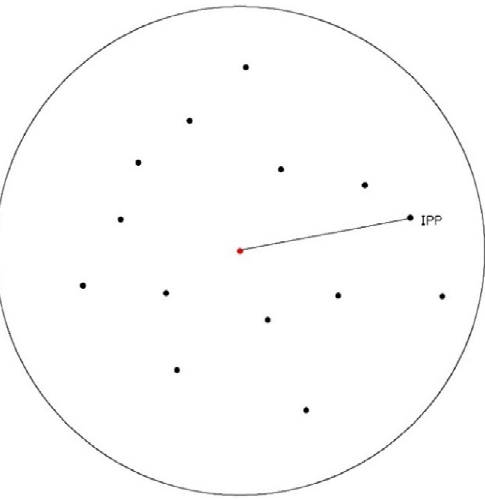
Figure 1. Sketch of the ionospheric pierce point (IPP) distribution.